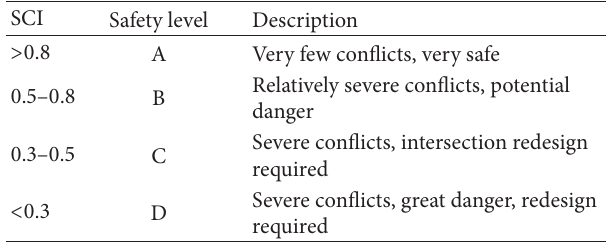
Table2:Regressiontableofleft-turnvehicleandpedestrianconflict.